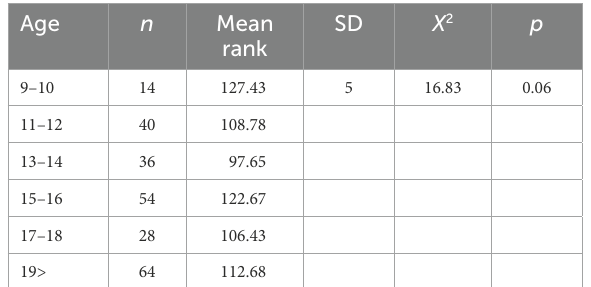
TABLE 8 Kruskal-Wallis test results of the coach’s leadership behavior scores by